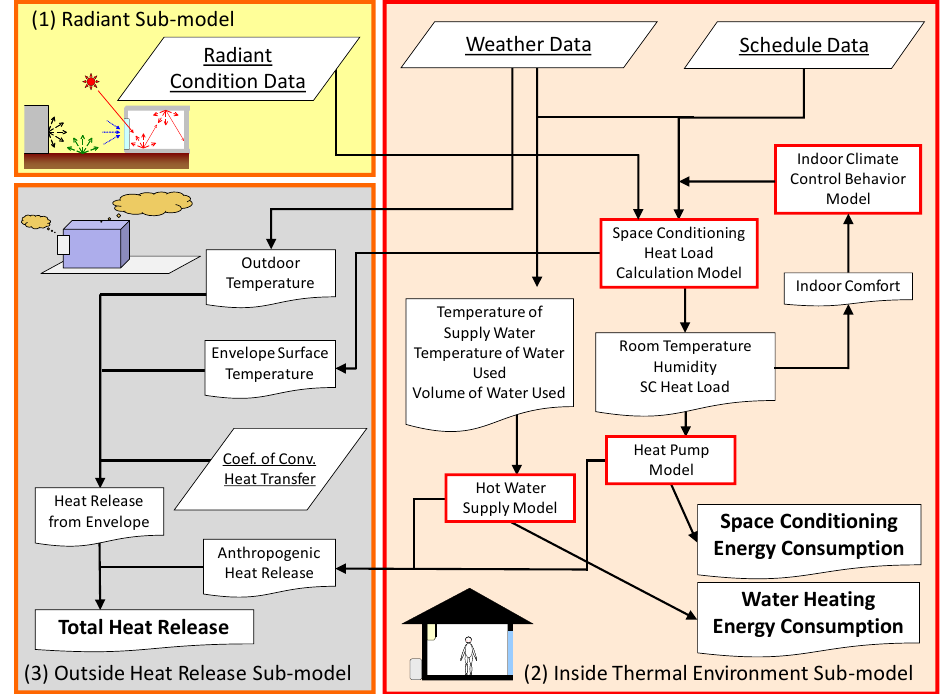
Figure 1. Outline of the SCIENCE-Outdoor model showing the flowchart of data between or inside each submodel: ( 1 ) radiant, ( 2 ) inside thermal environment, and ( 3 ) outside heat release.